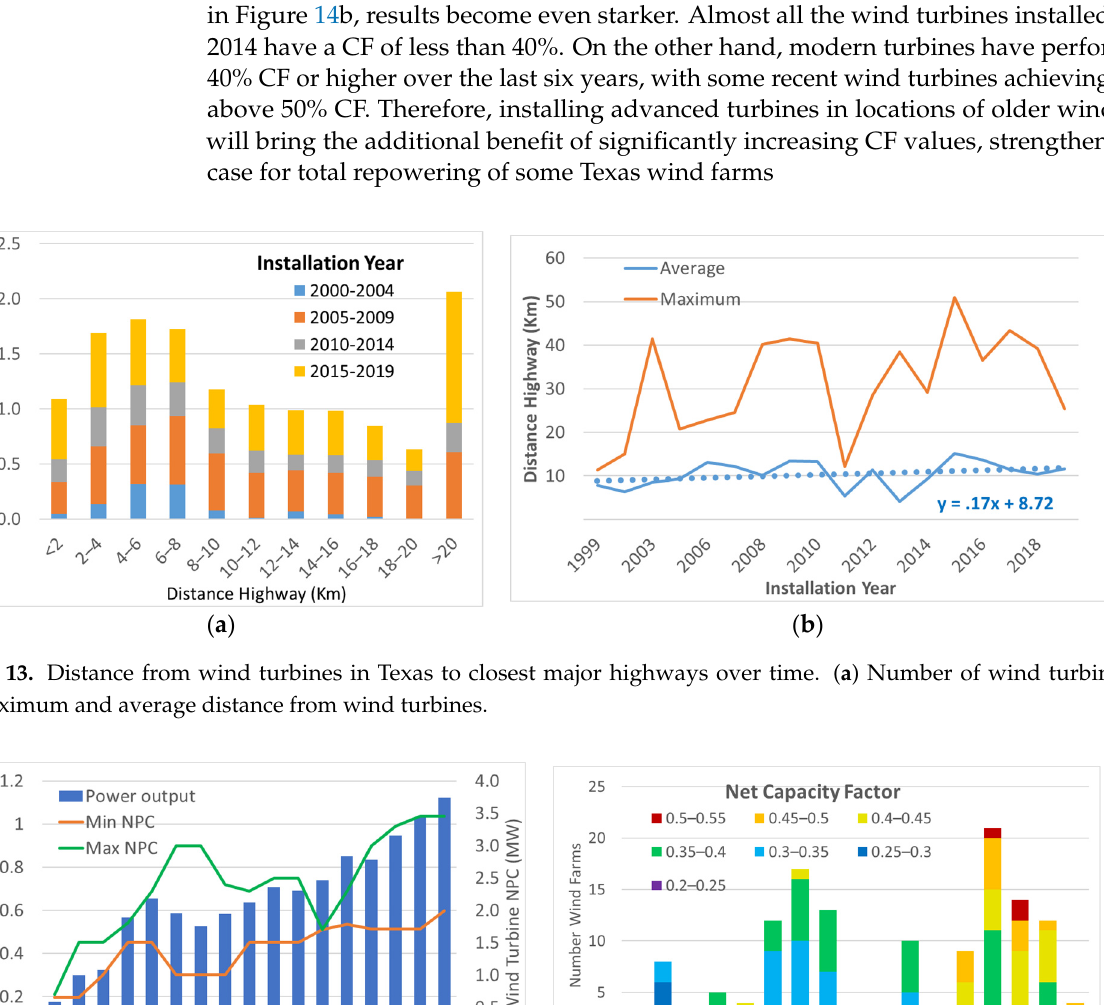
Figure 14. Power output from ERCOT’s Hourly Wind Generation Profiles according to installation year. ( a ) Individual wind turbines’ average performance. ( b ) Yearly average capacity factor for wind farms.